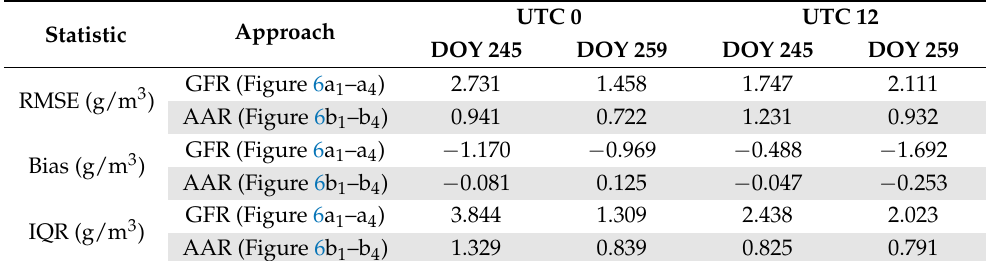
Table 2. The statistical results for each subfigure in Figure 6.